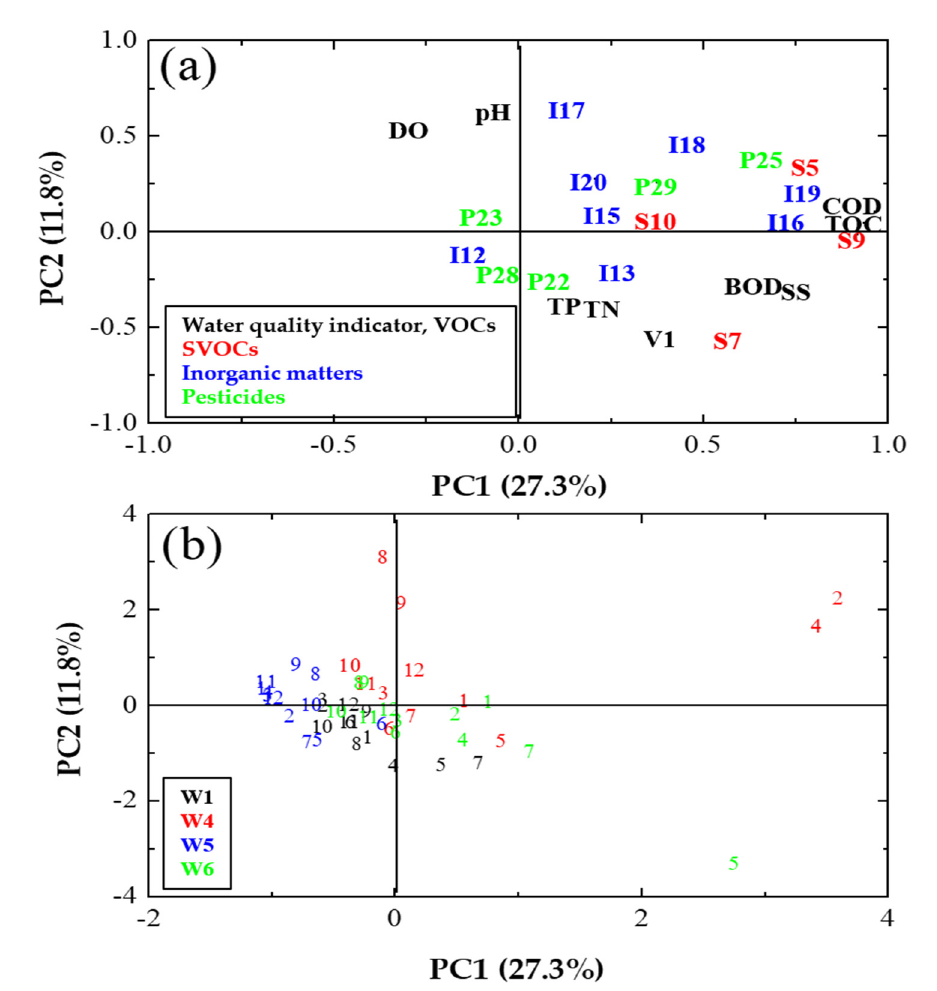
Figure 7. Distribution of ( a ) variables and ( b ) principal component analysis (PCA) results of the coastal streams with respect to the month. ( a ) V; VOCs, S; SVOCs, I; Inorganic matter, P; Pesticides, the number after the alphabet indicates each hazardous substance, see Table 1, ( b ) the number represents month (1 for January, 2 for February, and so on).